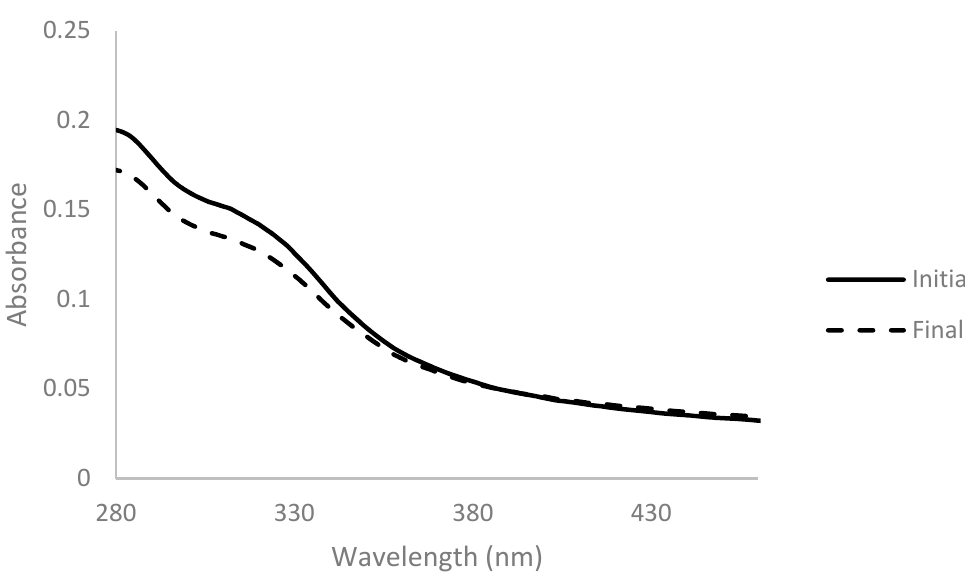
Figure 2. Absorbance spectra of arabinoxylan extract with 2% ( w / v ) of activated charcoal before (full line) and after 1 h of contact (dashed line), for a dilution ratio of 1:200. The spectrum obtained with 2% activated charcoal showed a more accentuated de- crease in absorbance after the addition when compared with the spectrum with only 0.5%.